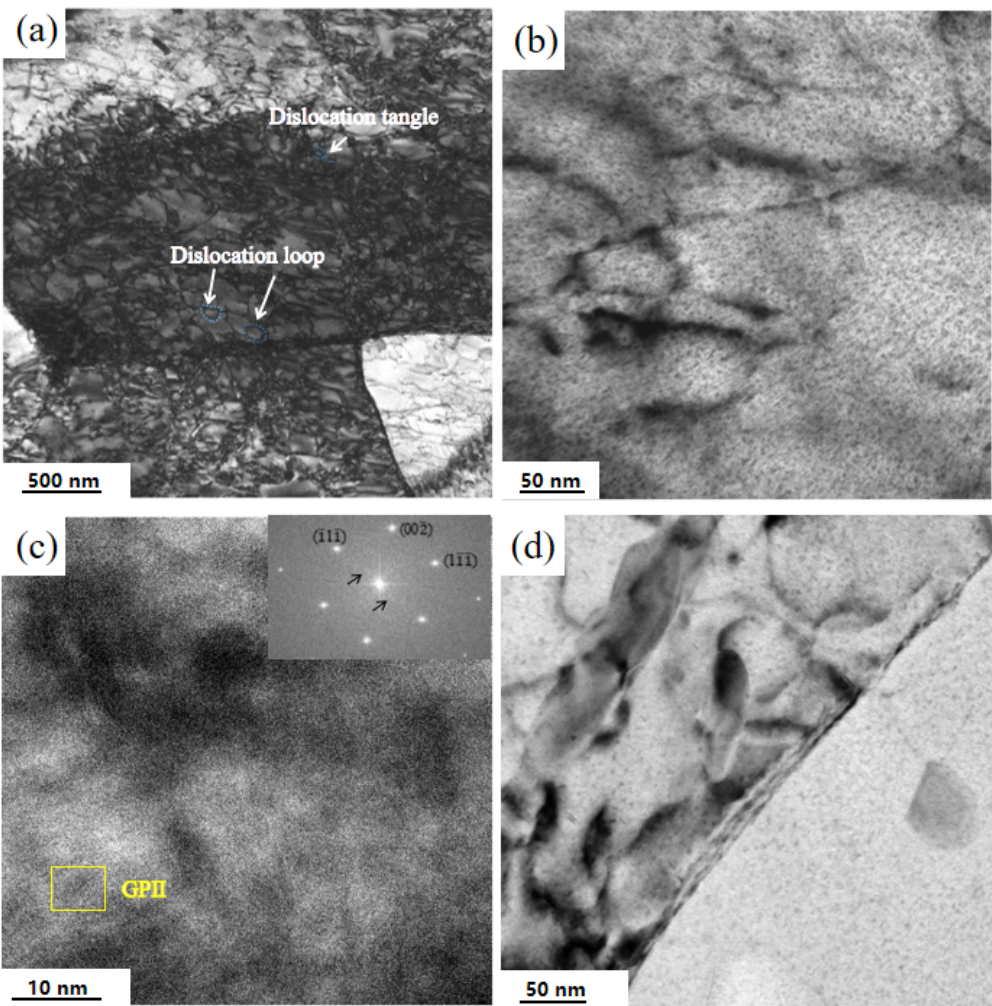
Figure 7. TEM images of the 7B04-P al alloy: ( a ) distribution of dislocation in grain; ( b ) in-grain distribution of GP zones and η’ precipitates; ( c ) HRTEM of GPII precipitates; ( d ) grain boundary.